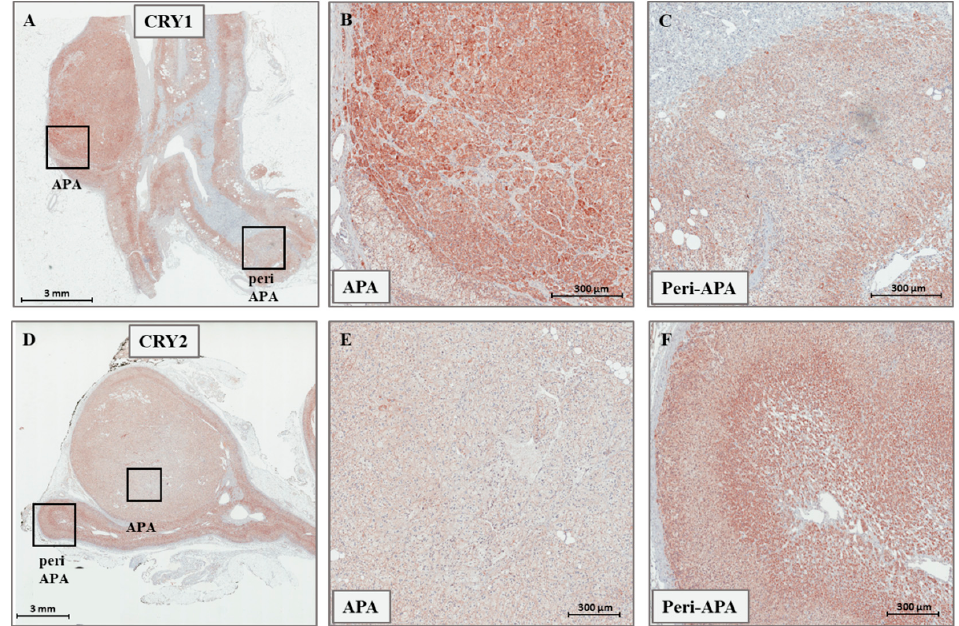
Figure 2. ( A – C ) Representative immunohistochemistry staining for CRY1 in APAs. ( D – F ) Representative immunohistochemistry staining for CRY2 in APAs. Magnifications in ( B , C ), and in ( E , F ) correspond to the boxed sections in ( A , D ), respectively.